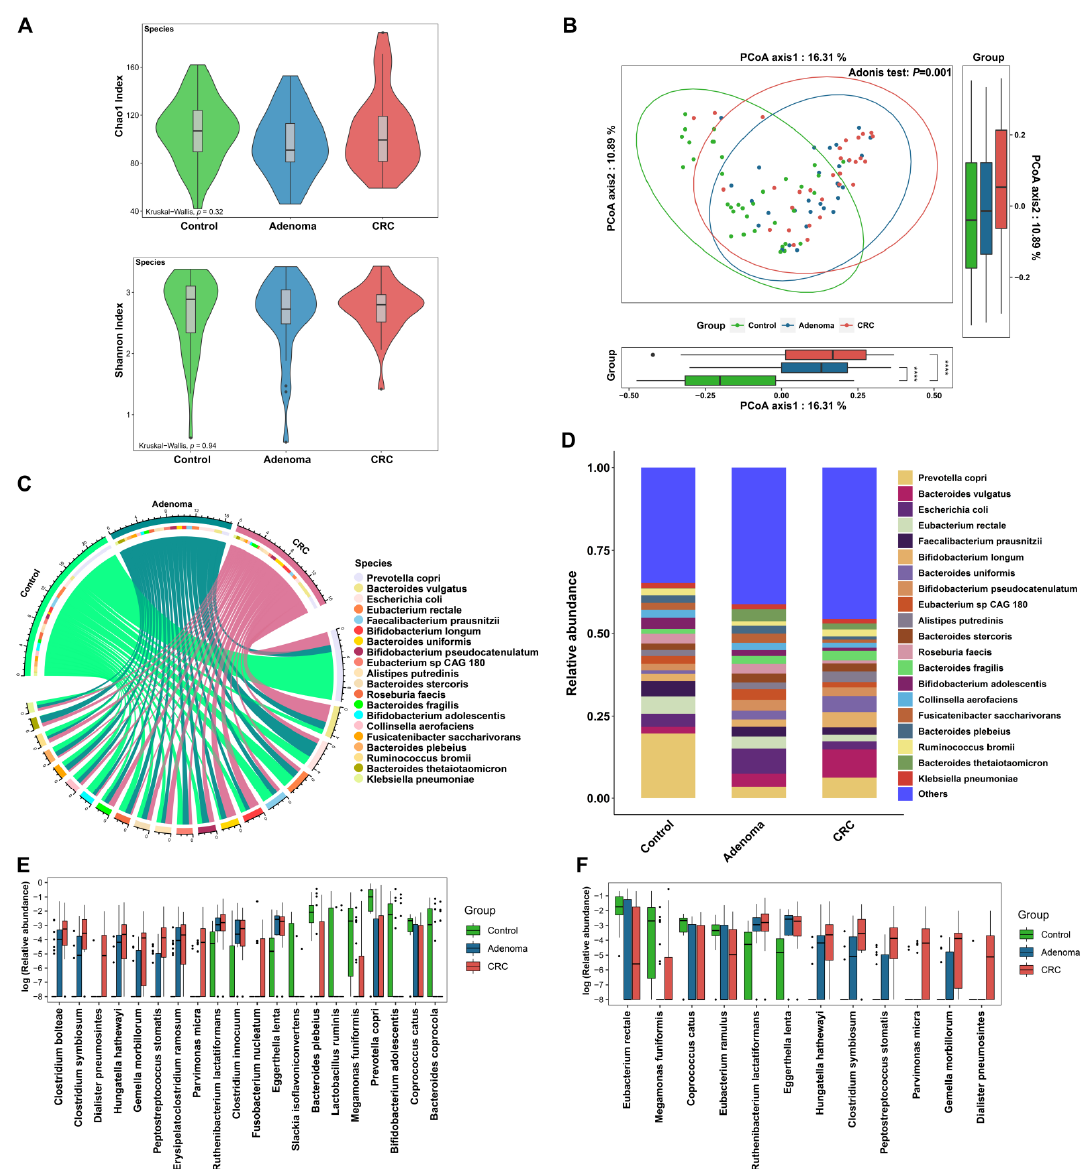
Figure 1. ( A ) The comparison of bacterial alpha diversity among three groups (healthy control (green), CRA (blue), and CRC (red)). ( B ) The comparison of bacterial beta diversity (measured by principal co-ordinates analysis, PCoA) among three groups. ( C ) The chord diagram of sample-species abundance for bacteria. The upper half of the circle represents different groups (control (green), adenoma (blue), and CRC (pink)). The bottom half of the circle shows the top 20 bacterial species in terms of relative abundance, with linked lines showing species–sample associations. Color identification of species is shown in the legend section. ( D ) Bar plots show the abundance distribution of the top 20 bacterial species with the highest overall relative abundance among the three groups. ( E ) The abundance distribution of the top 20 bacterial species with the most significant differences among the three groups (Kruskal–Wallis test, the smaller the p -adj value, the more significant the difference). ( F ) The box plots show the relative abundance distribution of the 12 bacterial markers identified by the random forest model among the three groups (the three diagnostic models constructed contain a total of 12 different bacteria, as detailed below and in Figure 2). Black points in subfigures E and F indicate outliers. ****, p <